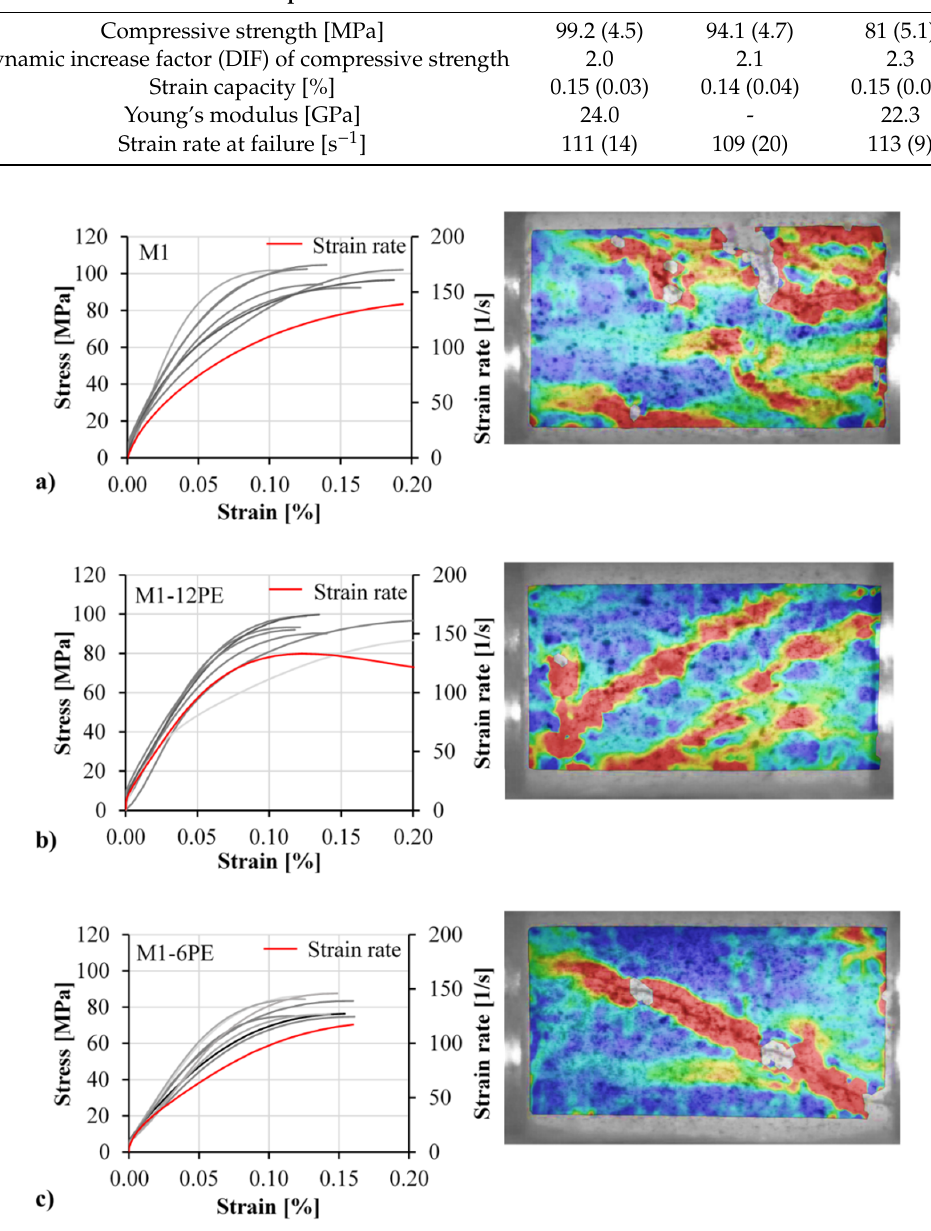
Figure 10 . Stress-strain curves and the corresponding typical failure modes of the specimens (DIC Figure 10. Stress-straincurvesandthecorrespondingtypicalfailuremodesofthespecimens(DICimages) images) obtained in SHPB for mixtures: ( a ) M1, ( b ) M1-12PE and ( c ) M1-6PE. obtained in SHPB for mixtures: ( a ) M1, ( b ) M1-12PE and ( c )